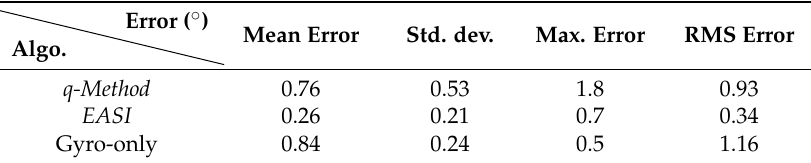
Figure 10. Rover heading angle estimation during the 2.5 h static test. Comparison of the EASI algorithm and the Optimization based q ‐ Method . Table 2. Statistical comparison of heading estimation algorithms. Table 2. Statistical comparison of heading estimation algorithms.